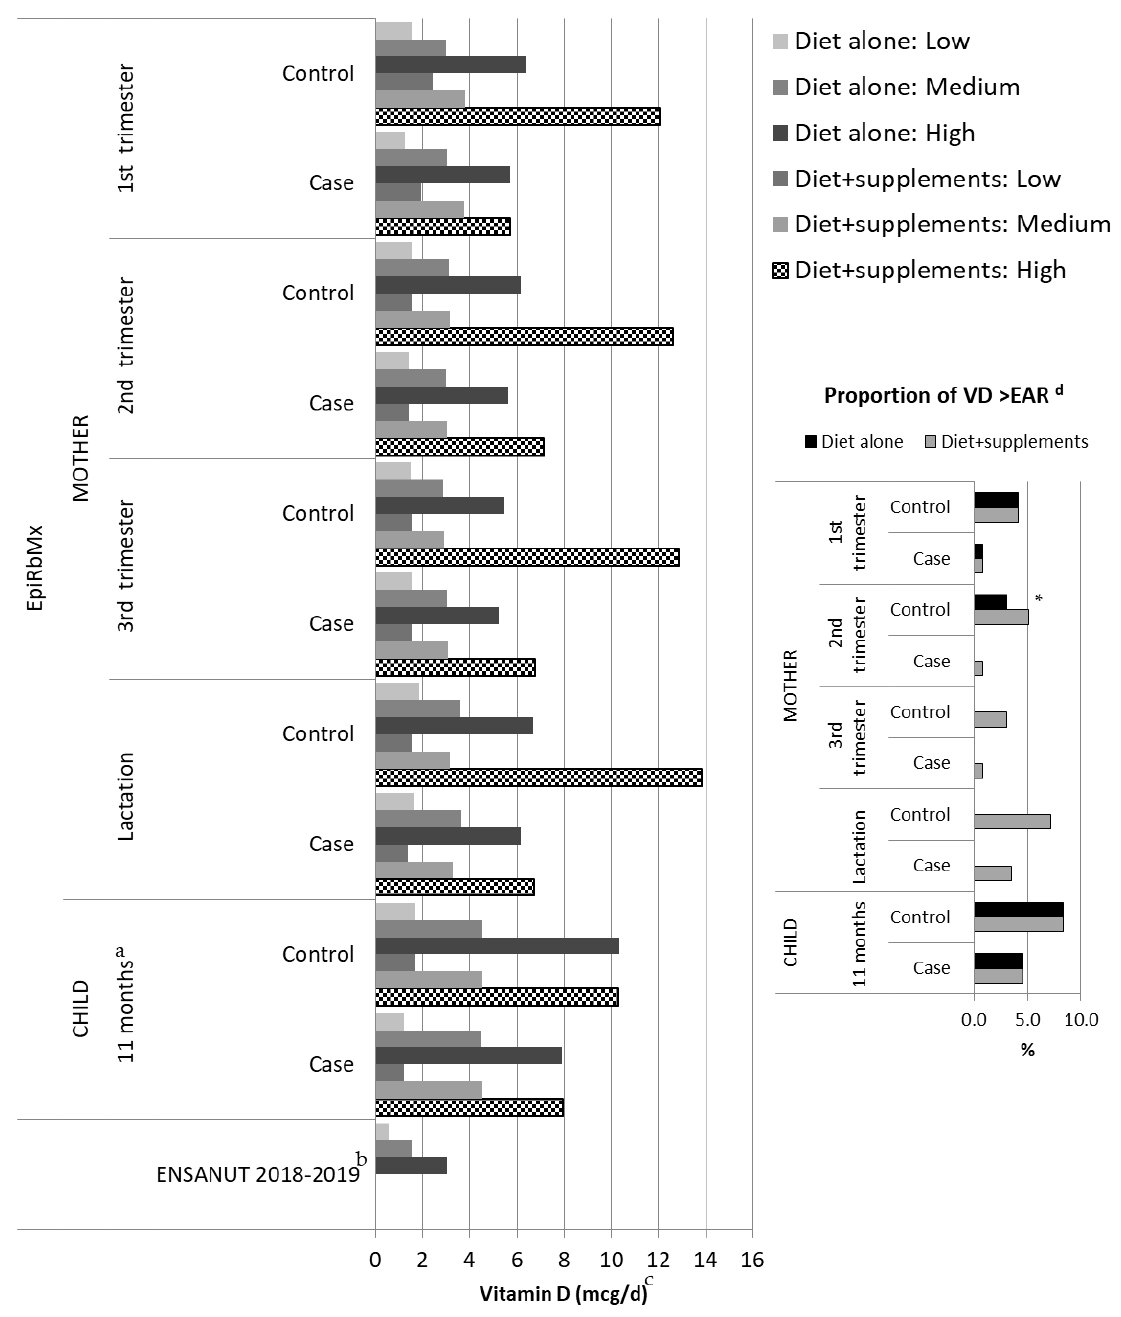
a Mean daily intake of vitamin D (VD) in tertiles, women and children of EpiRbMx and ENSANUT 2018–2019 Figure 1. by evaluation period. a From starting regular feeding complete diet at 11 months of age, b no estimation of supplement intake available, c mean daily intake of vitamin D (ug/day) from diet alone or plus supplements, d EAR: Estimated Average Requirement, proportion of mother and children EpiRbMx with consumption >10 ug/day of VD (1 to 8 cases), * p < 0.05 differences between cases and controls, Case n = 115, Control n = 97, ENSANUT 2018–2019 n =